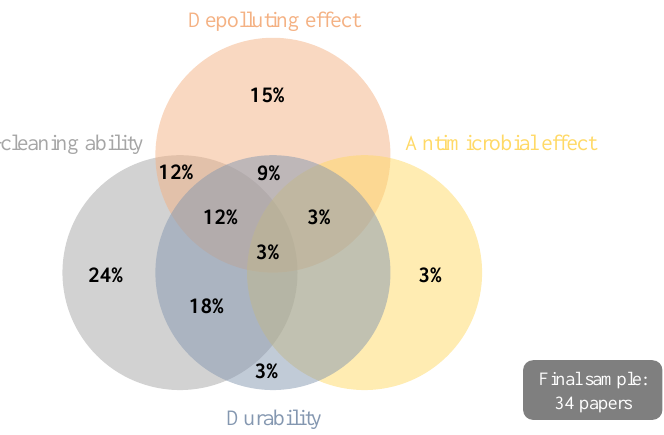
Figure 3. Proportion of papers addressing the research subjects: self-cleaning ability, depollution effect, antimicrobial effect, and durability.